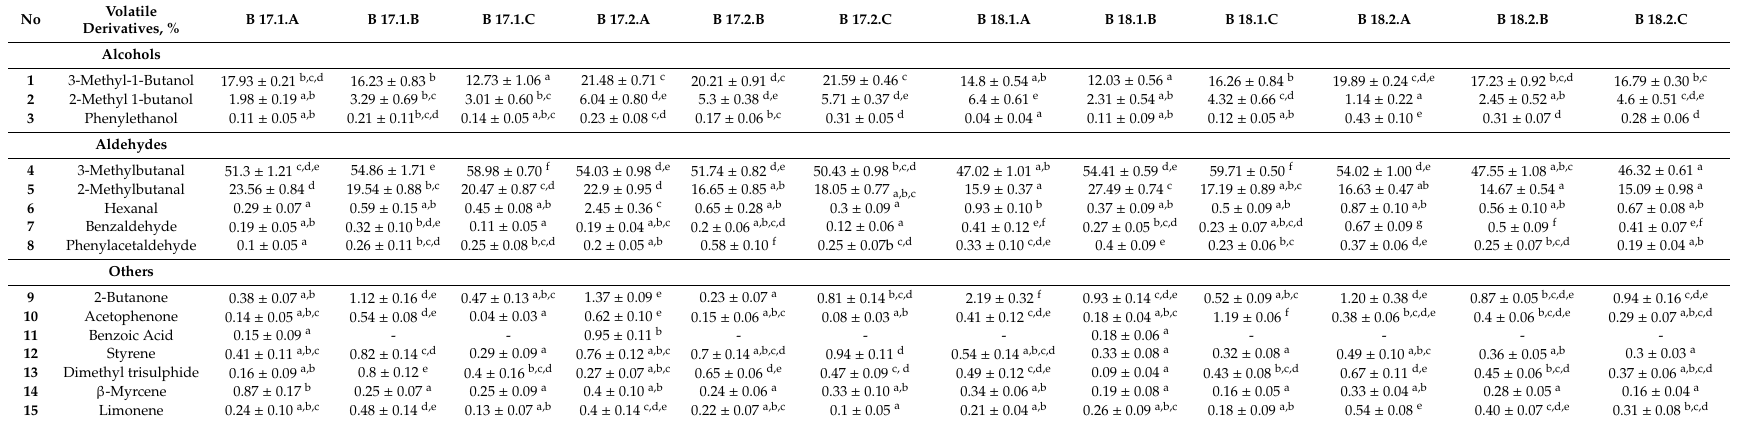
Table 4. Volatile derivatives in bread